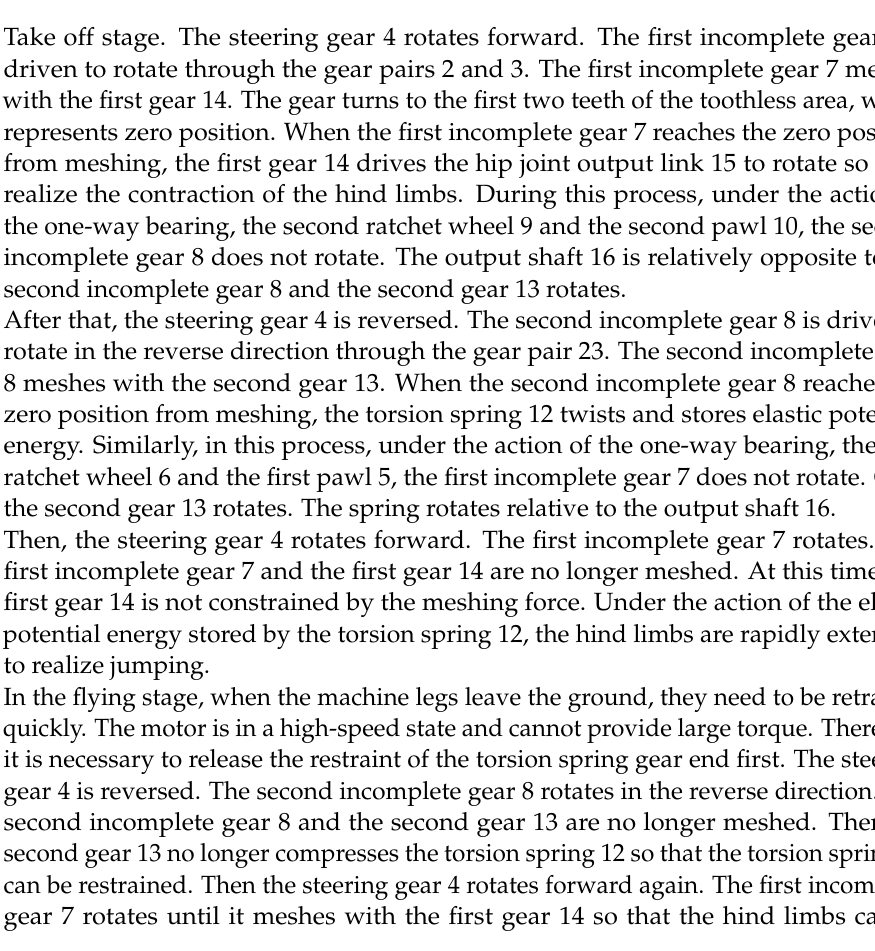
Figure 10. Jump control process of elastic energy storage trigger mechanism.